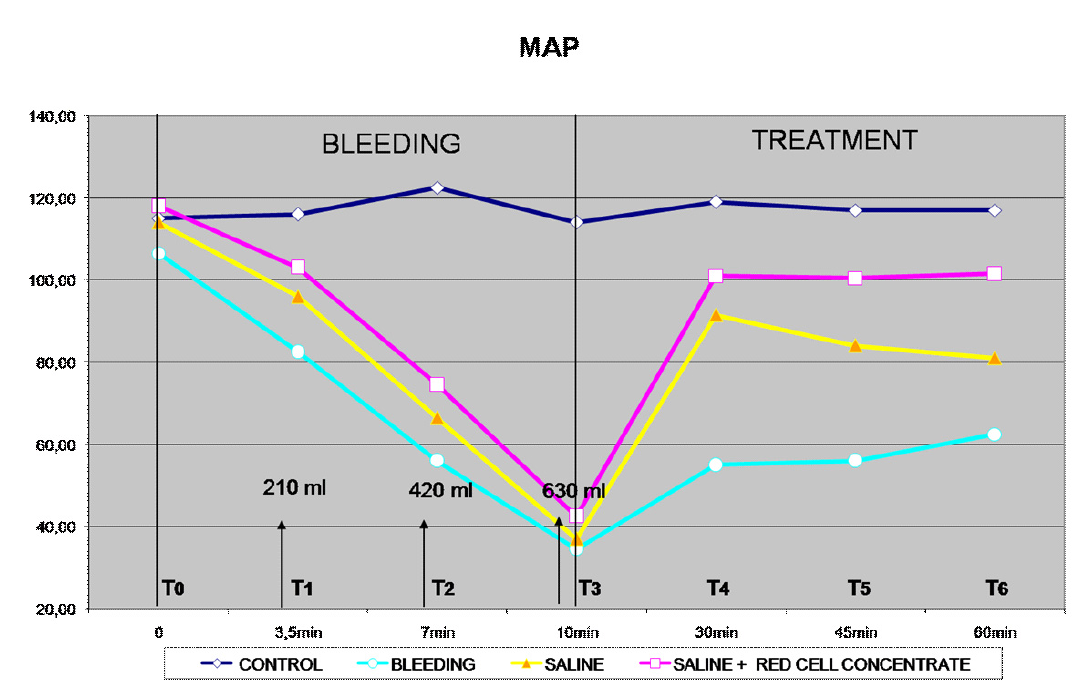
FIGURE 1 - Evolution of heart rate after hemorrhagic shock and respective therapy